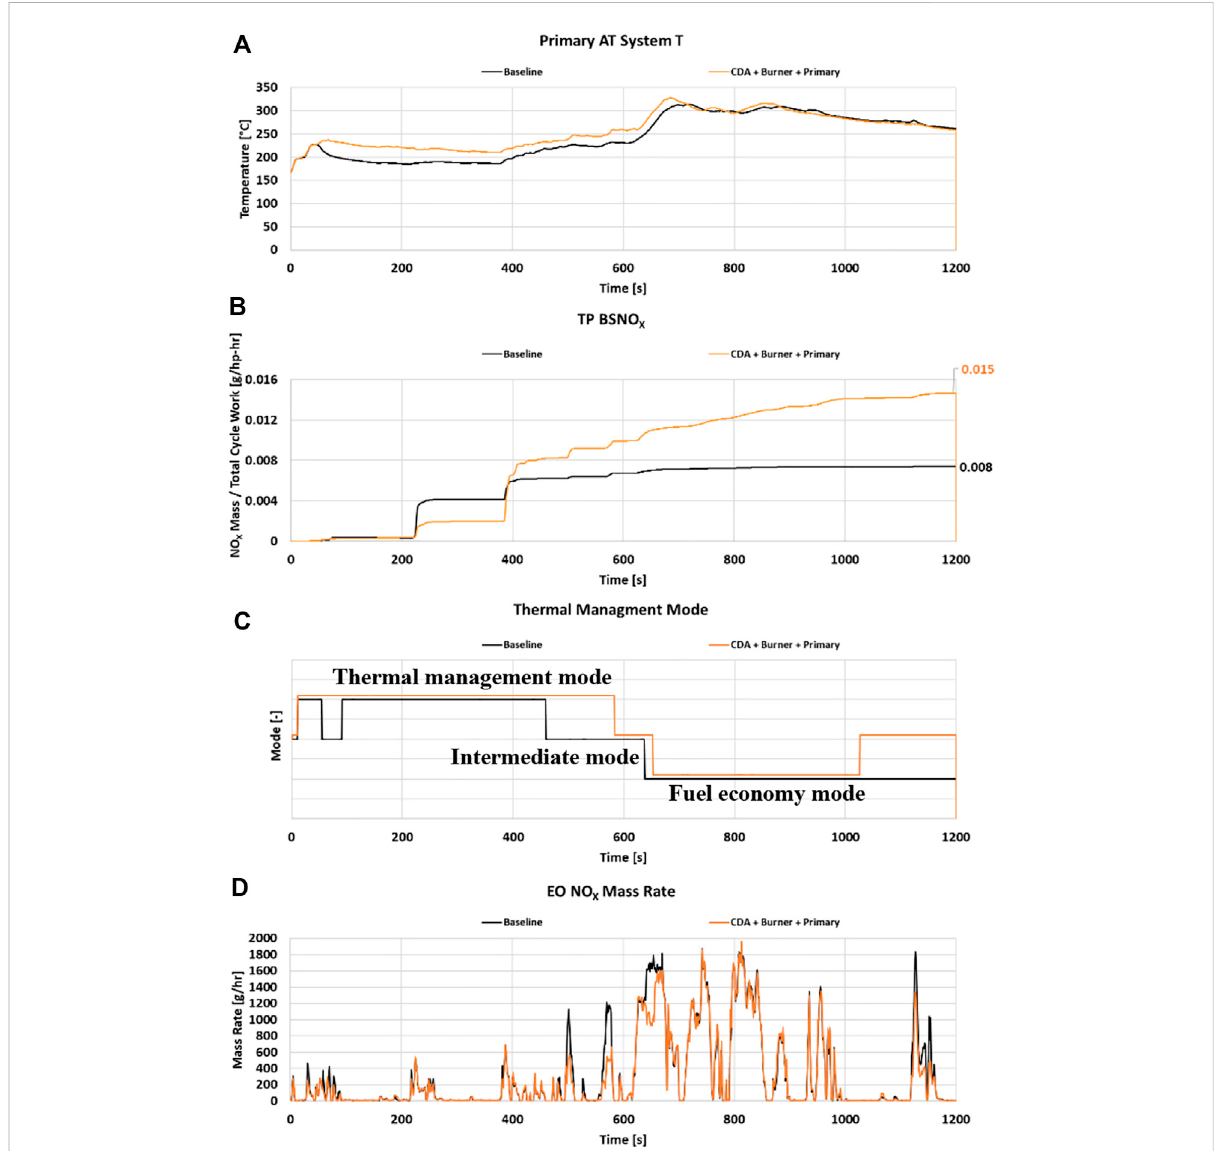
FIGURE 9 Hot start HD-FTP measurements comparisons between Baseline and CDA + Burner + Primary Systems. (A) Primary system temperature, (B) Cumulative TP BSNO X , (C) Engine mode comparison, (D) Engine outlet NO X mass rate.